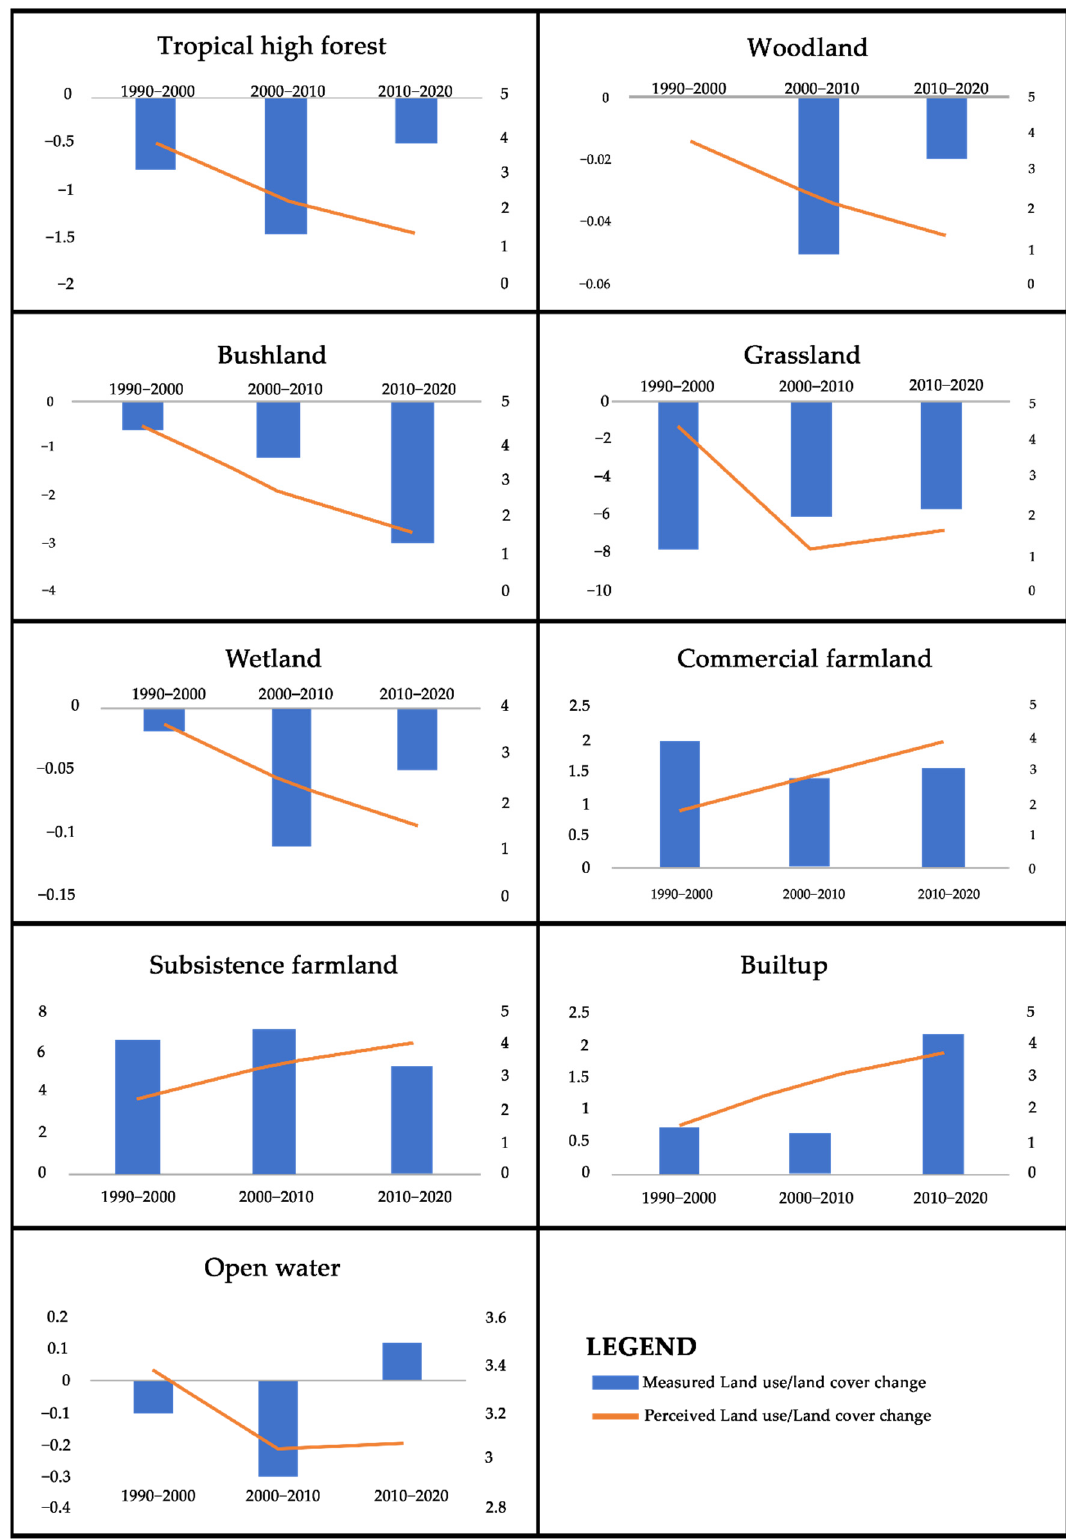
Figure 3. Combined plot of perceived and measured LULCC in Budongo–Bugoma landscape.